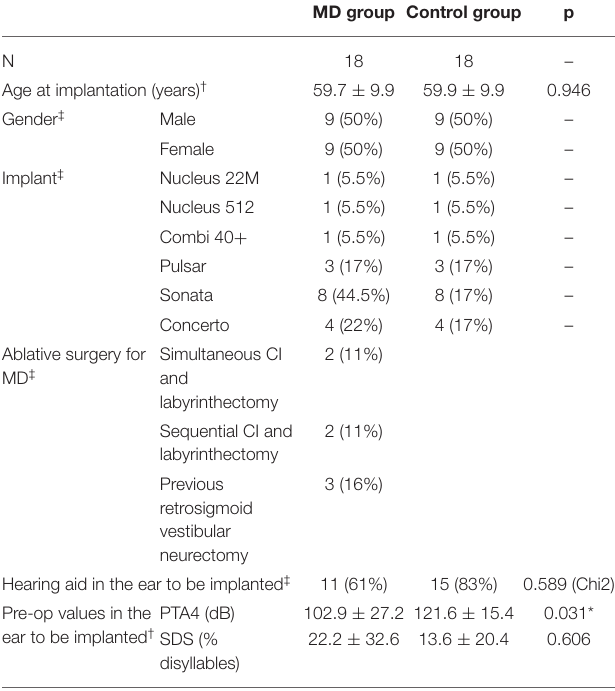
TABLE 1 | Patients’